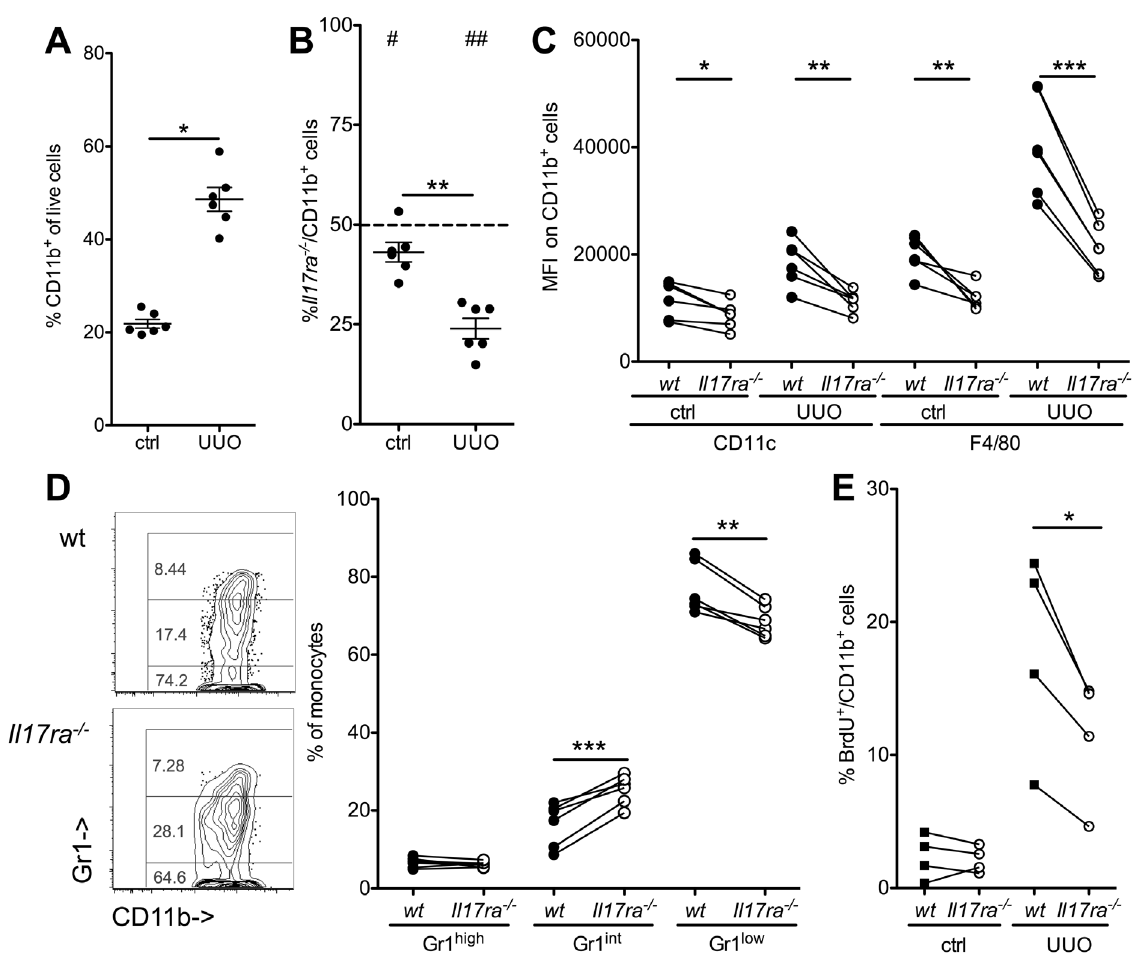
Figure 9. Reduced renal macrophage generation in response to urethral obstruction in the absence of IL-17 receptor. Renal fibrosis was induced by unilateral ureteral obstruction (UUO) in mixed wt/ Il17ra -/- bone marrow chimeric mice. Myeloid cell accumulation in the obstructed kidney was assessed for wt and Il17ra -/- cells in identical environments ( A,B ) Total CD11b + myeloid cell infiltration to the kidney (A, ctrl=contralateral kidney, UUO=obstructed kidney) and their genotype (B, # indicates significance level against expected 50% wt ratio, *between UUO and ctrl) was determined. ( C,D ) For assessment of differentiation, renal myeloid cell CD11c, F4/80 (C) and Gr1 (D) surface marker expression was tested (n=6 from 2 independent transplantations, paired t-tests). ( E ) Renal myeloid cell proliferation was assessed 24 h after a single injection of BrdU